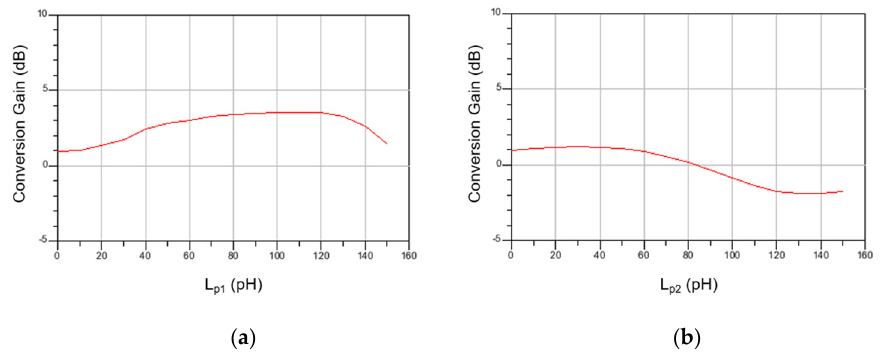
Figure 10. Simulated CG at high frequency according to ( a ) L p1 and ( b ) L p2 .